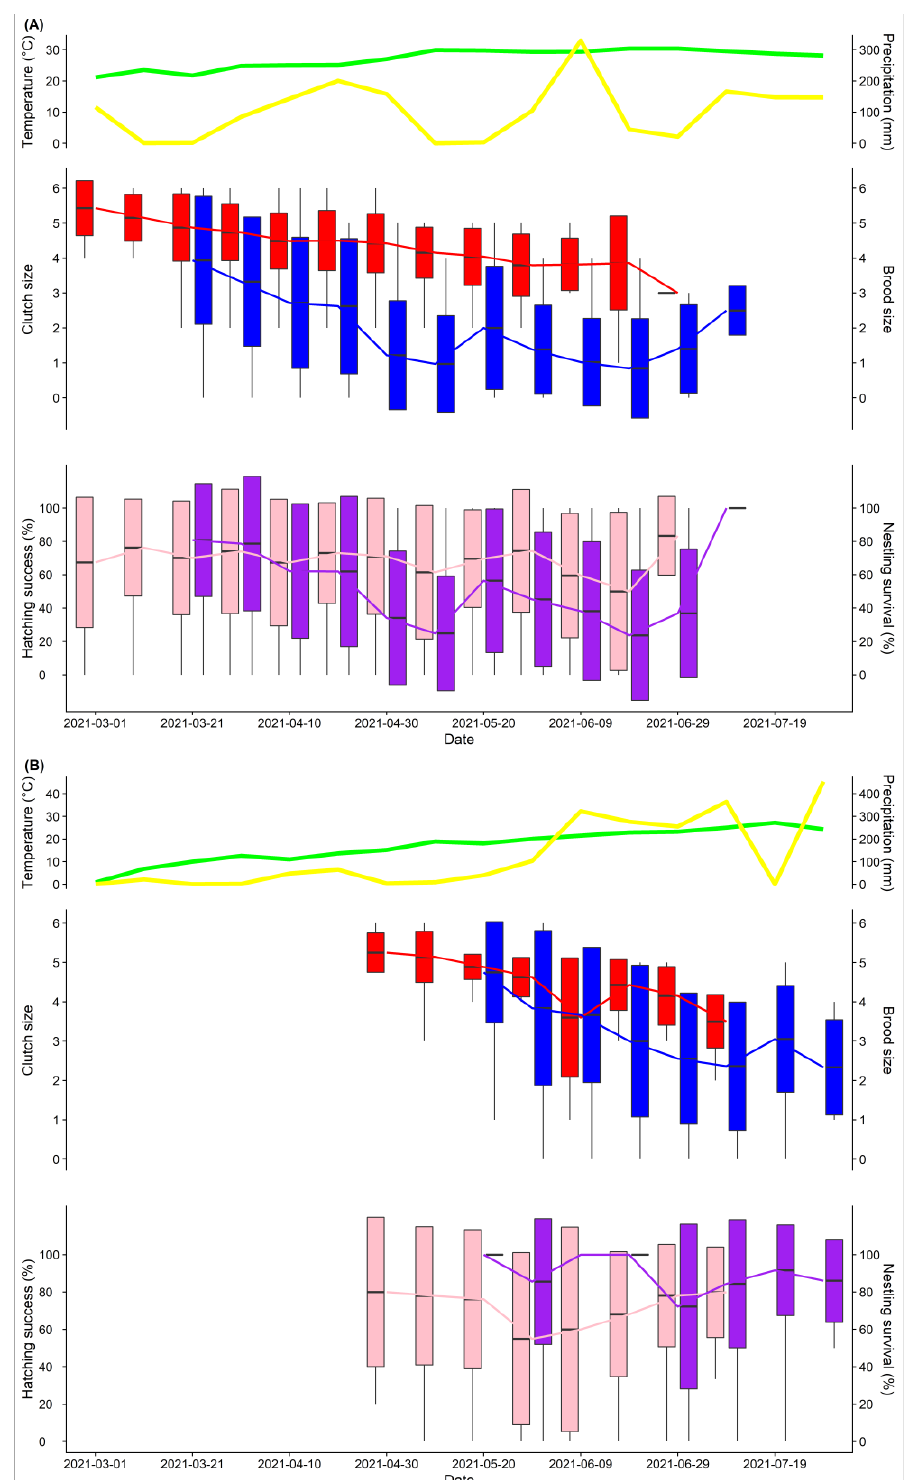
Figure 2. Weather (temperature, precipitation) and the reproductive performances of the Barn Swallow in the two study sites from March to July 2021. Egg-laying dates were from late February to early July at the tropical site ( A ) and from late April to late July at the temperate site ( B ). Upper part: the mean daytime temperature is shown in green and the total daytime precipitation is shown in yellow. Middle and lower part: Clutch size ( red ), brood size ( blue ), hatching success ( pink ), and nestling survival ( purple ) are shown with boxplots, in which the means, mean ± SD, and the range of the data are shown. Data are presented in 10-day periods.